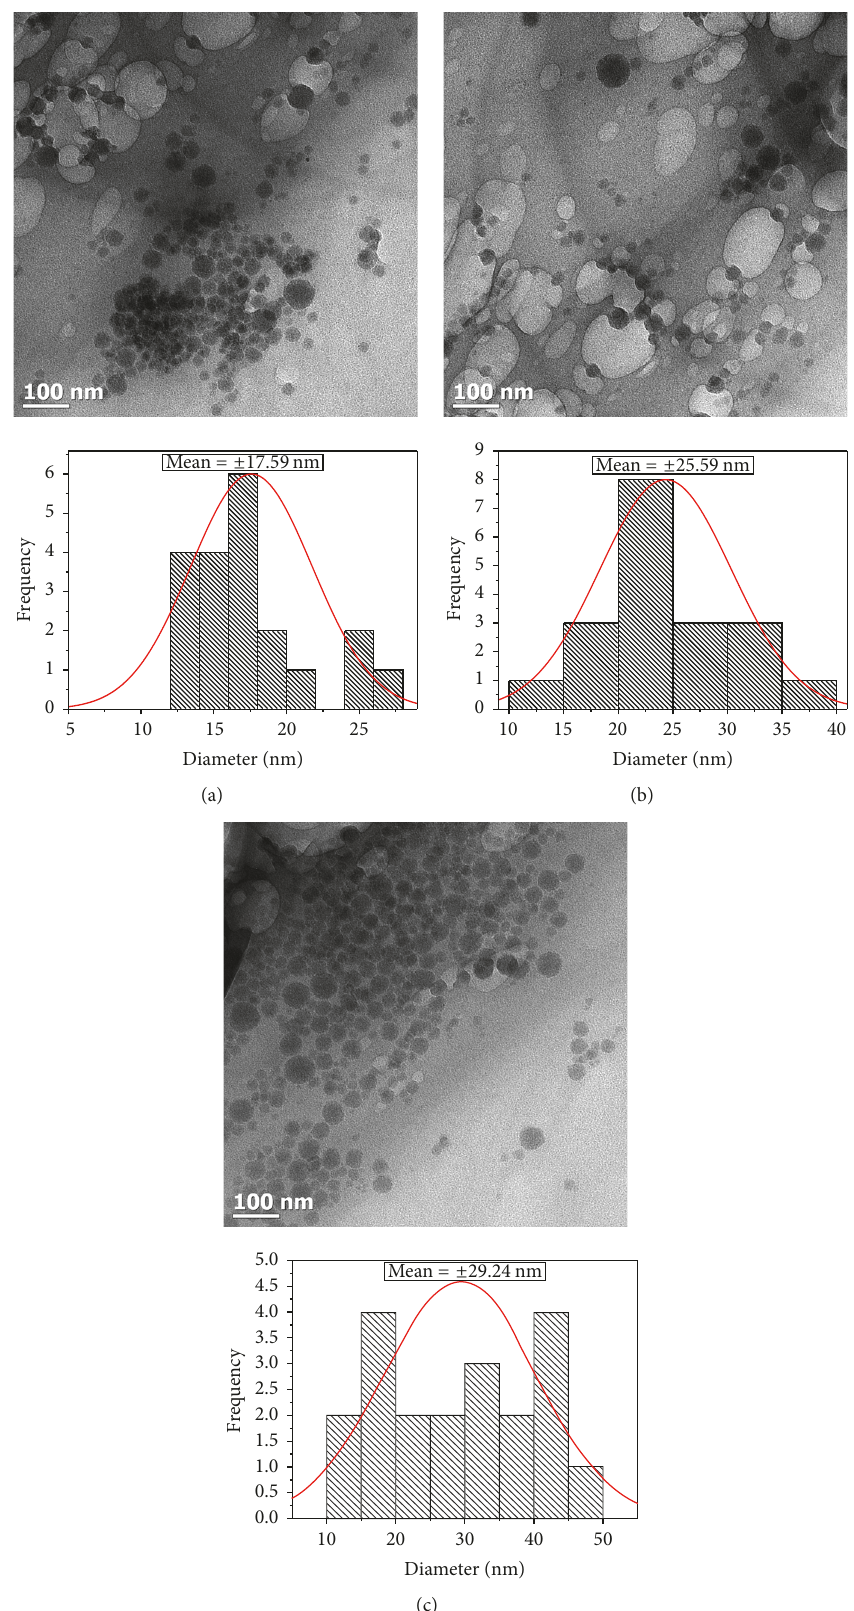
Figure 4: TEM images and frequency distribution of HDA-capped CdO nanoparticles synthesized at 120 (a), 160 (b), and 200 ∘ C